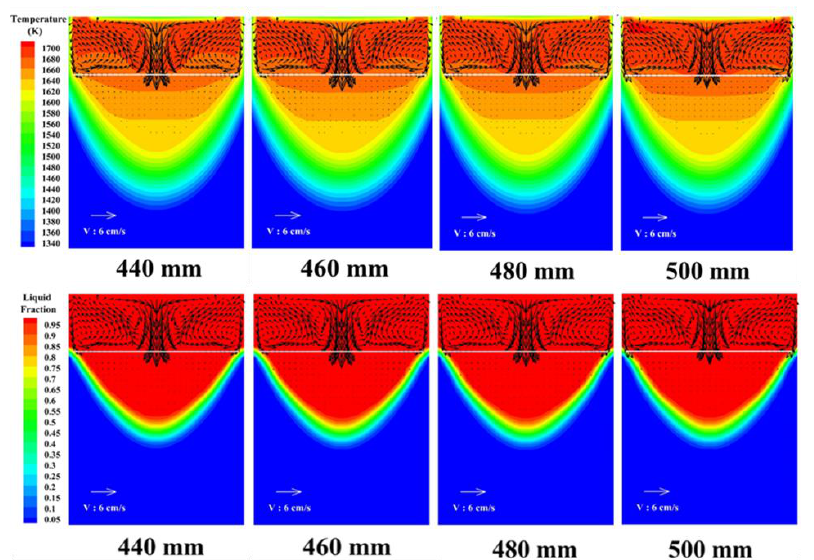
Figure 2. The influence of electrode diameter on temperature field, flow field distribution and molten pool distribution.